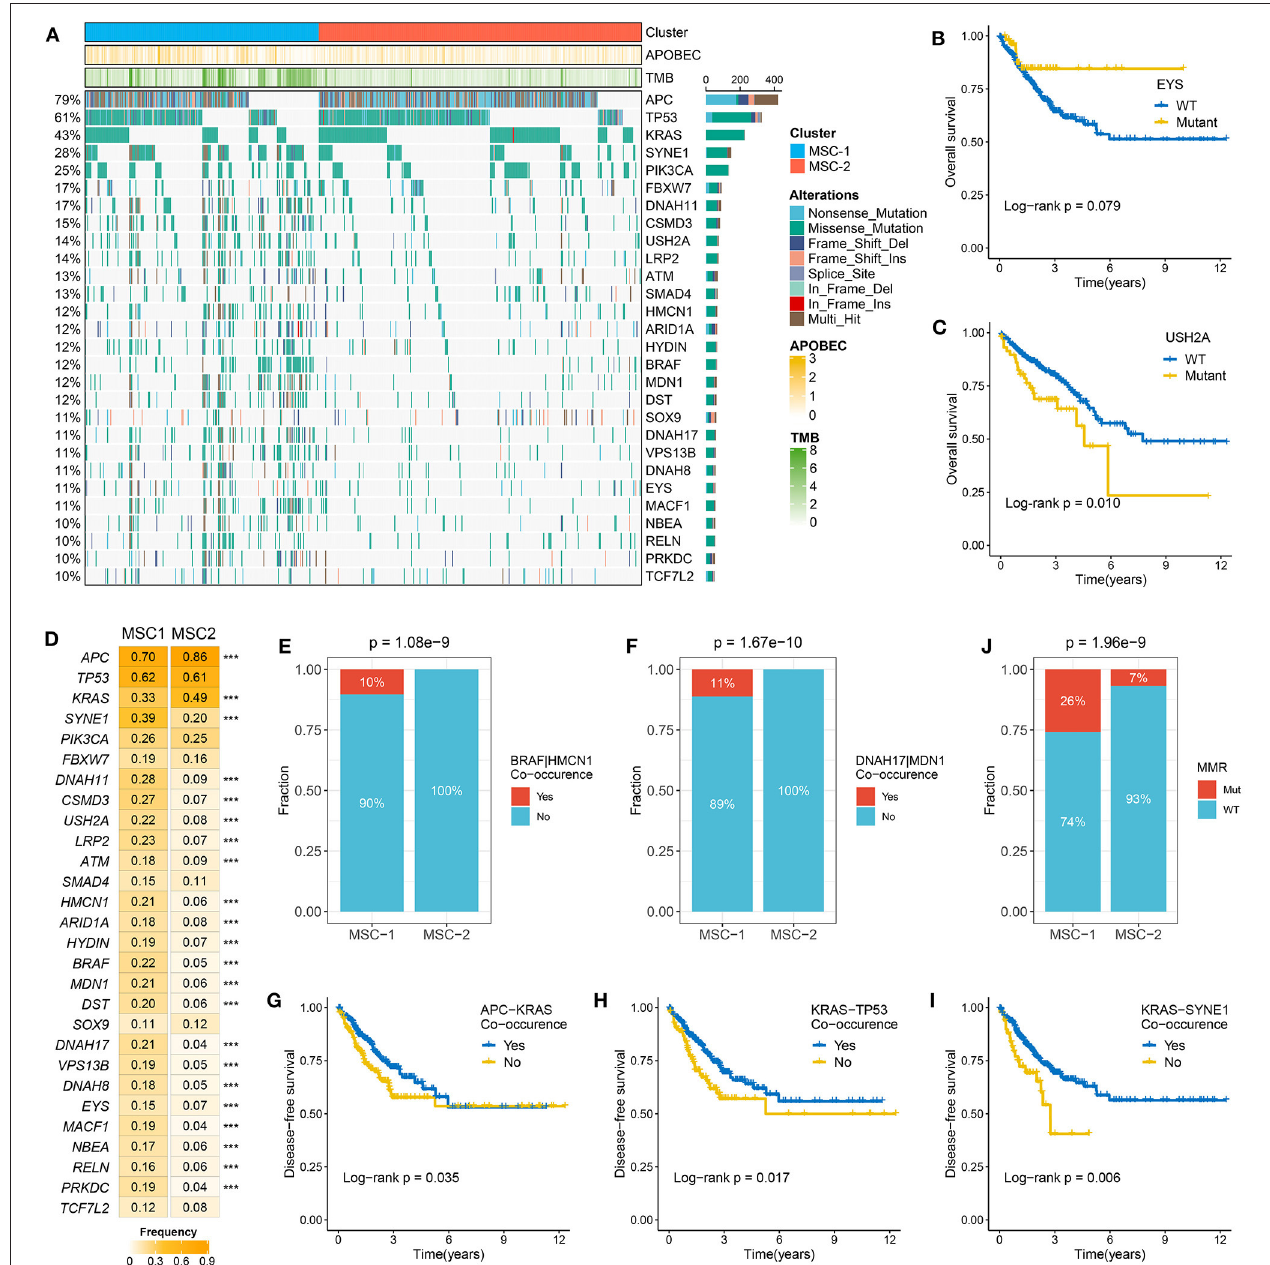
FIGURE 2 | The mutation driven genes in colorectal cancer (CRC). (A) Mutational oncoplot of mutation driven genes in MSC-1 and MSC-2. Rows are genes and columns are tumor samples. (B,C) Kaplan–Meier survival analysis of EYS (B) and USH2A mutations (C) . (D) The mutation frequency of mutational drivers in two subtypes, *** P < 0.001. (E,F) The relative proportion of BRAF-HMCN (E) and DNAH17-MDN1 (F) co-occurrences in two subtypes. (J) The relative proportion of patients with the MMR genes mutations in two subtypes. (G–I) Kaplan–Meier survival analysis of APC–KRAS (G) , KRAS–TP53 (H) , and KRAS–SYNE1 (I)